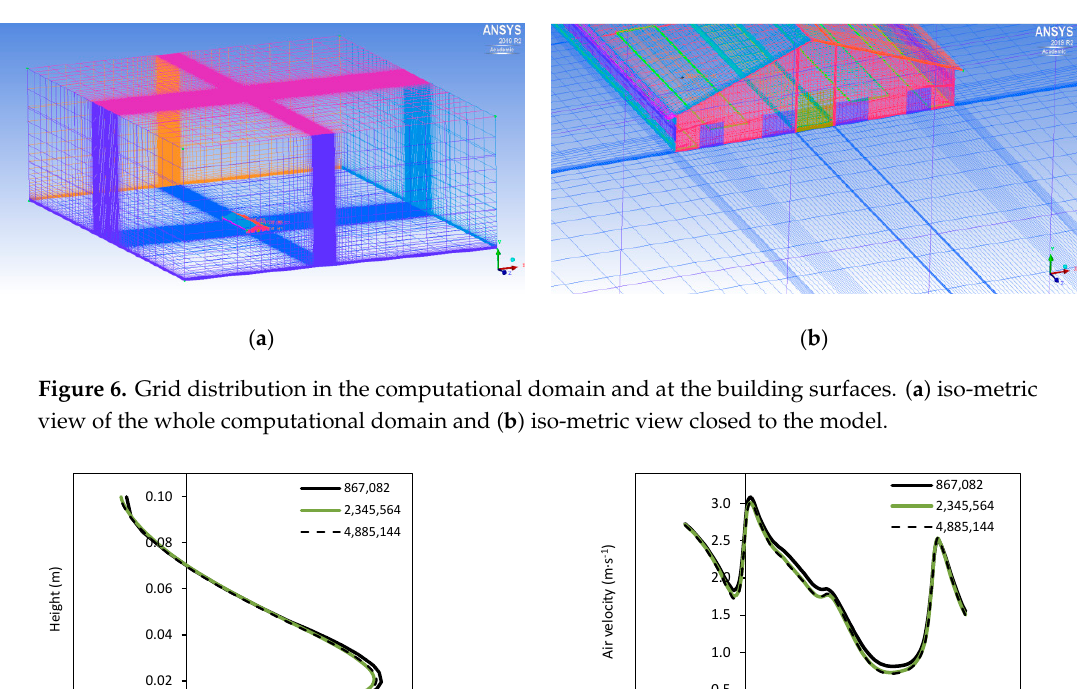
Figure 6. Grid distribution in the computational domain and at the building surfaces. ( a ) iso-metric view of the whole computational domain and ( b ) iso-metric view closed to the model.